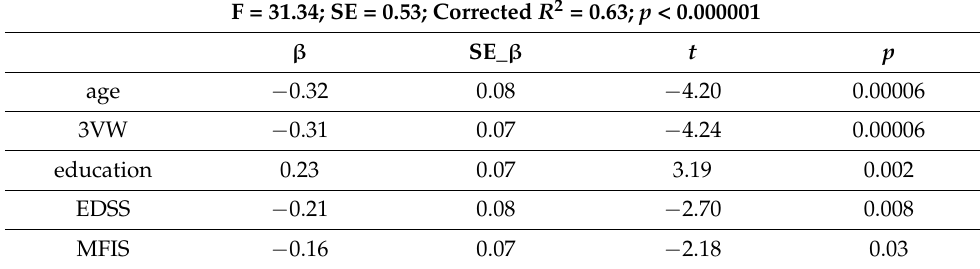
Table 3. Multiple regression model for the cognitive z-scores.